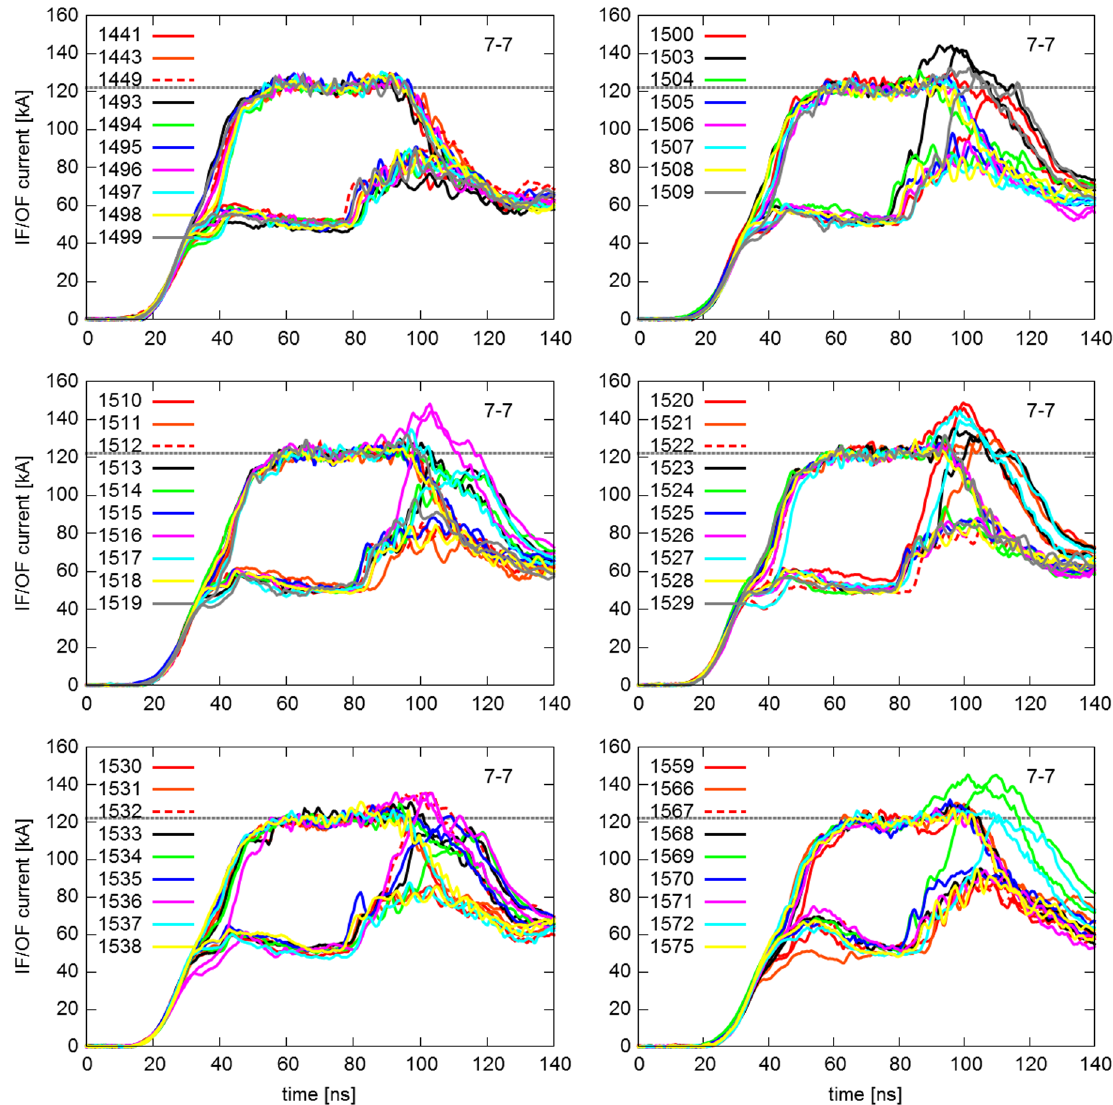
FIG. 3. The IF and OF currents for SMP diode shots with a 7-mm diameter cathode needle and a 7-mm AK gap. The gray dotted lines are the average OF in the first 10 ns at peak